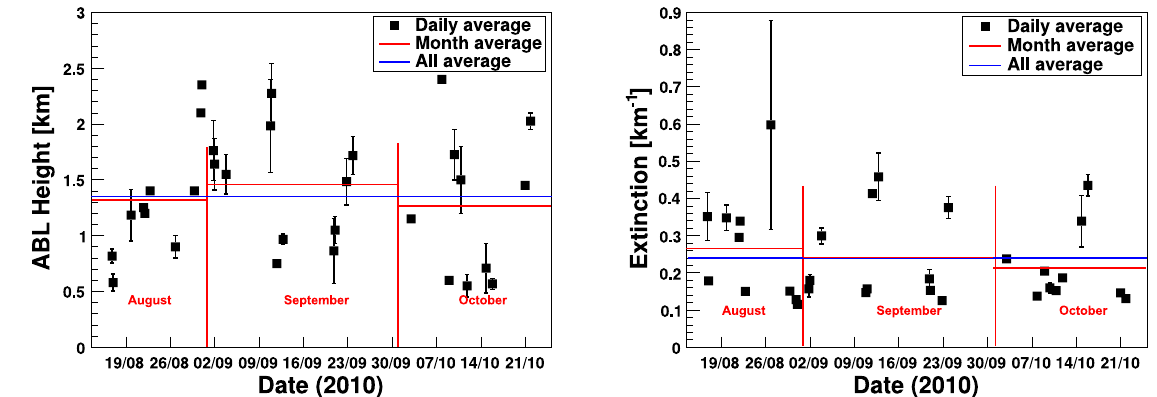
Figure 7. Atmospheric boundary layer (ABL) heights derived from the 2D RHI scanning measurements between 16 August and 21 October 2010. Also shown is the average height of the ABL in each month and in all three months. Height is given relative to the altitude of the LiDAR site.